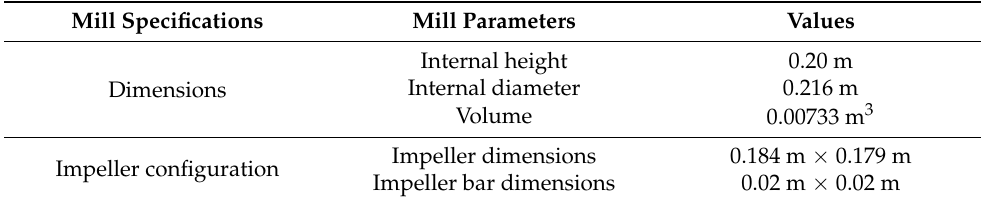
Table 1. Specifications of the mill.